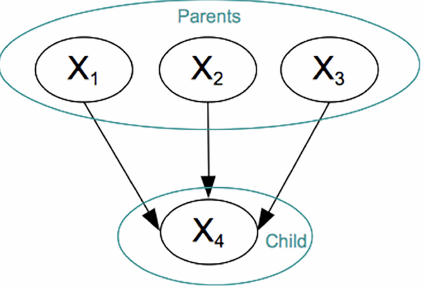
Figure 7. BN graph with four